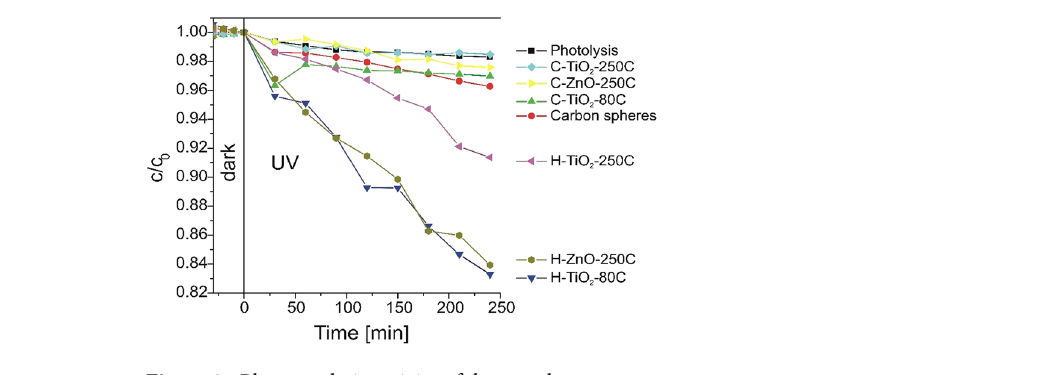
Figure 8. Photocatalytic activity of the samples.